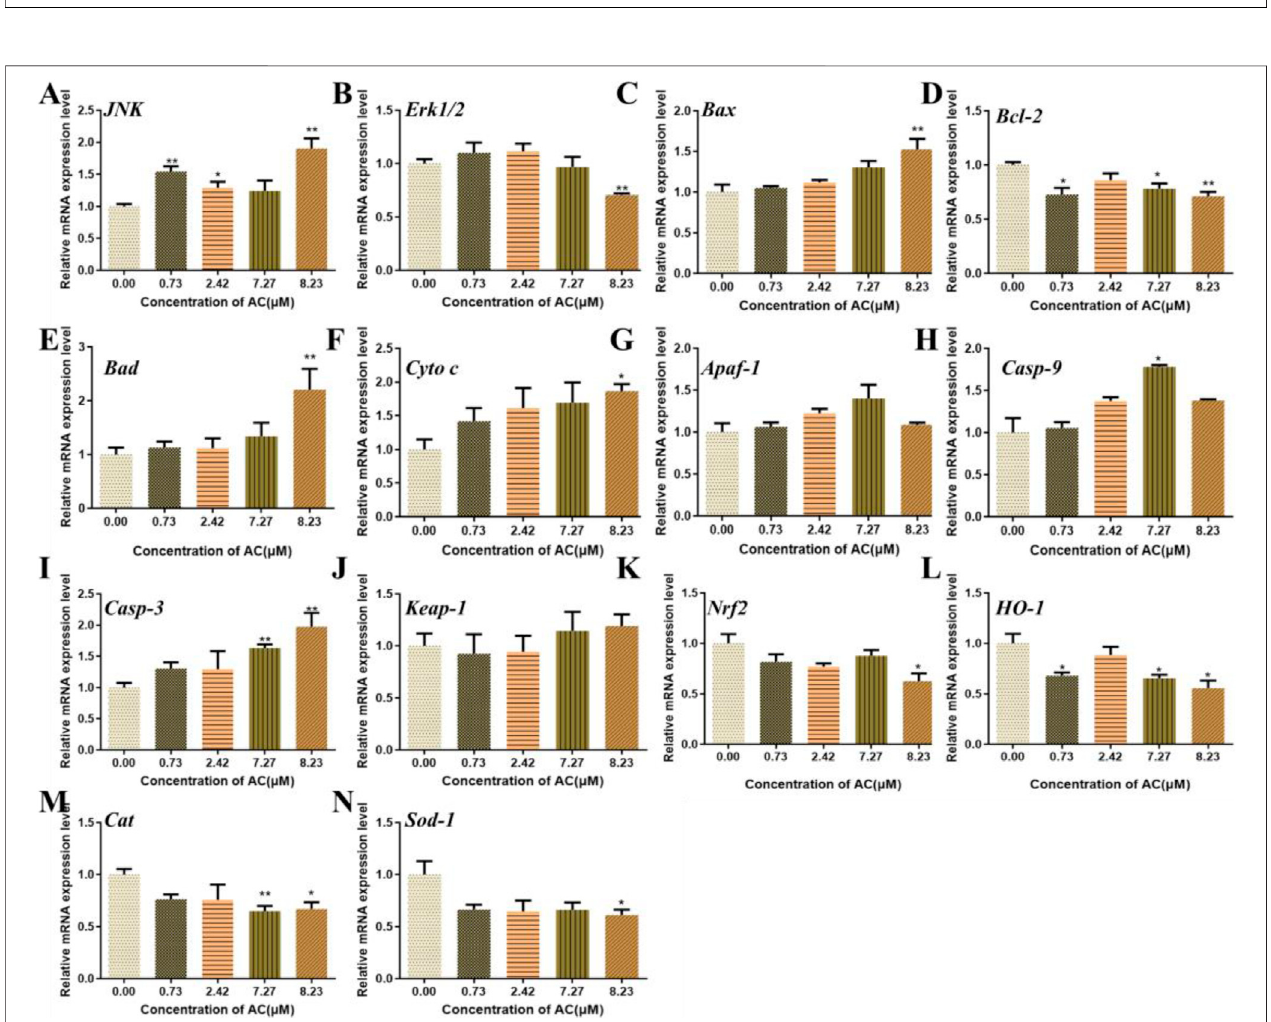
FIGURE 7 | Effects of AC on the expression of oxidative stress, JNK , and mitochondrial apoptosis-related genes in zebra fi sh larvae at 96 hpf.